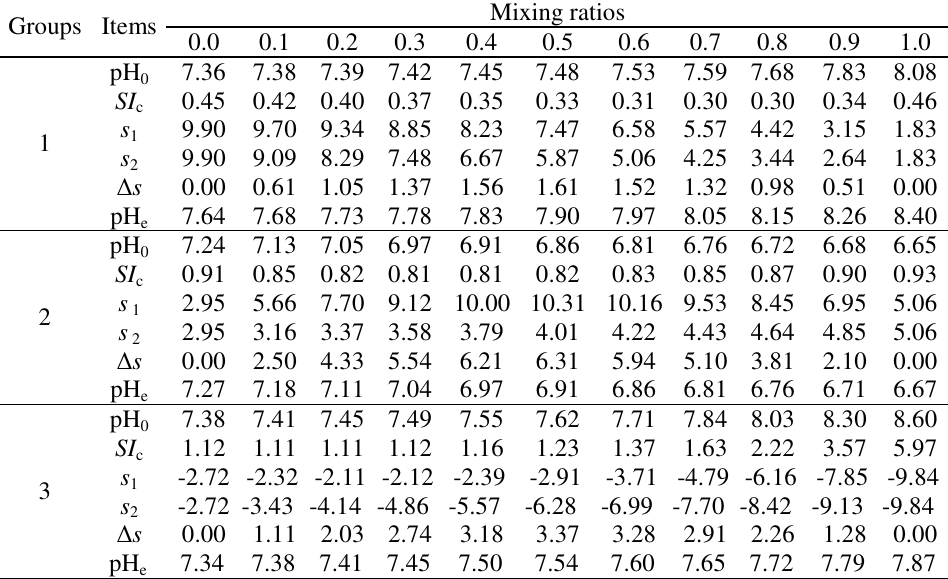
Figure 1. Dissolution (precipitation) amount of CaCO Table 3. Calculated results for mixed water